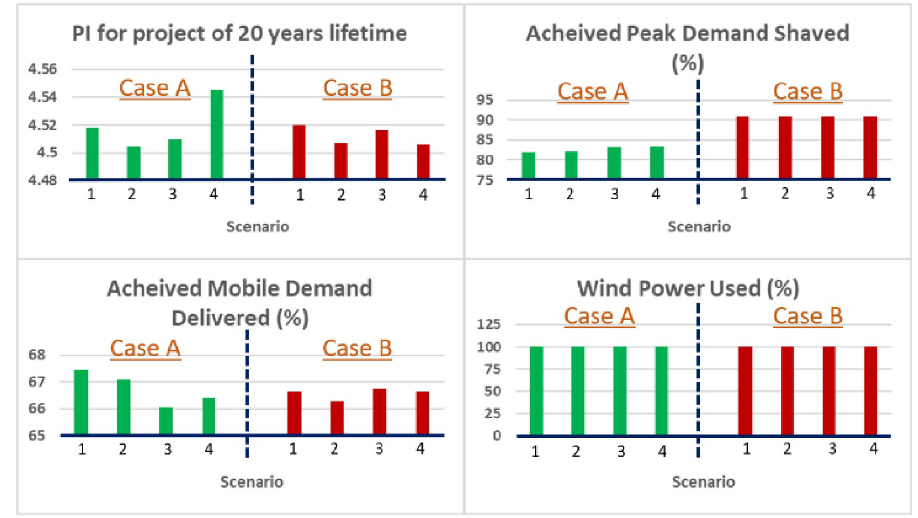
Fig 10. Four BESS performance indices (PI and Indices 2–4) with the optimized control variables in the four scenarios with the DC priority (case A) and the AC priority (case B).